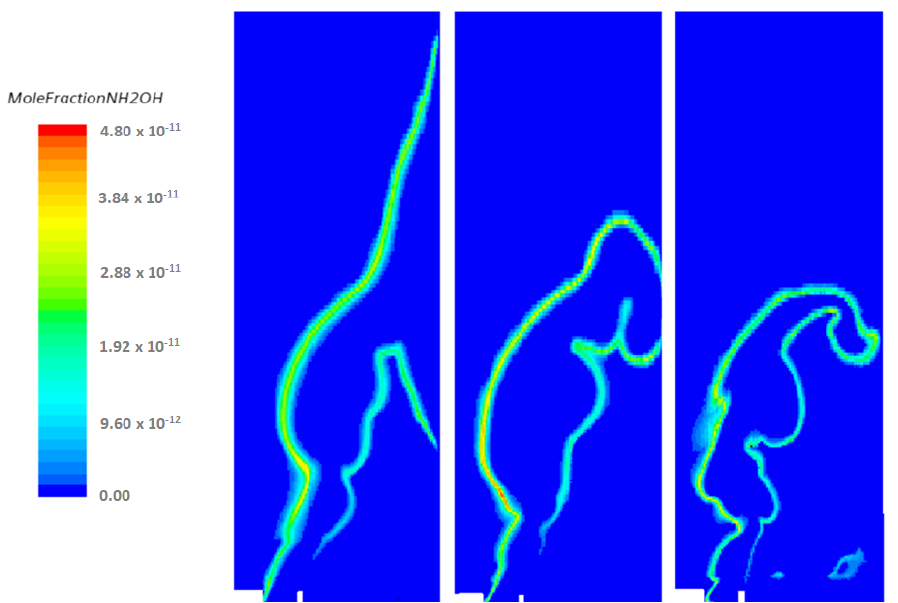
Figure 11. Instantaneous mole fraction of CH. ( Left ) 20/80; ( Centre ) 40/60; ( Right ) 60/40 (vol%) me- thane/ammonia blends under stoichiometric conditions.